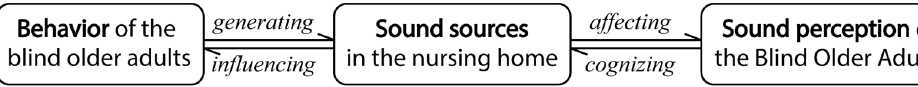
Figure 1. Research framework.